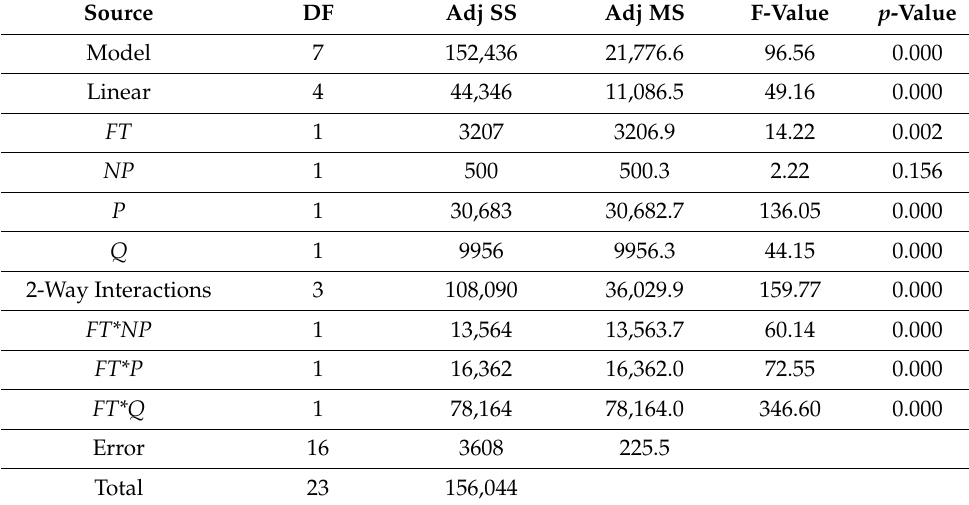
Table 4. Results of ANOVA analysis of the cutting force F r